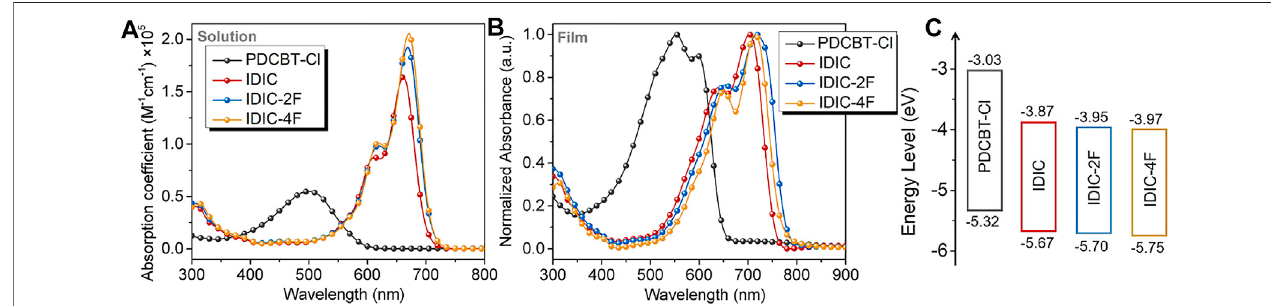
FIGURE2|(A) Solution(dissolvedinchloroformwiththeconcentrationof10 − 5 mol/L)and (B) fi lmabsorptionspectraofPDCBT-ClandIDIC-xF. (C) Theschematic energy levels of PDCBT-Cl and